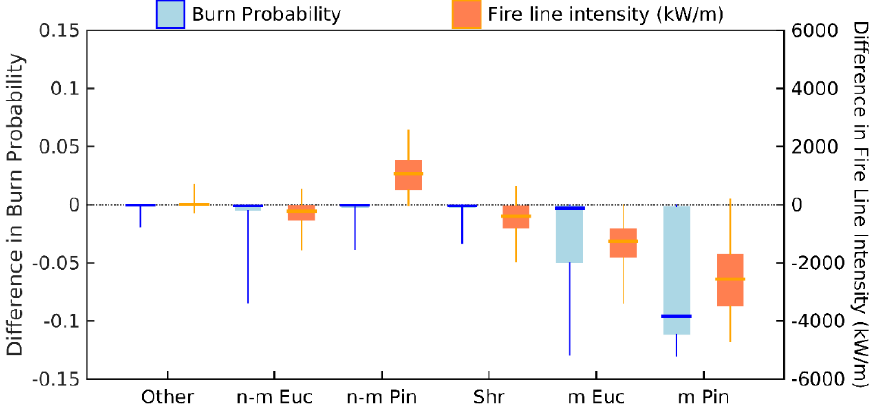
Figure 9. The impact of integrating fuel uncertainty in the estimated burn probability and fireline intensity for the main land use and cover types. Classes are non-managed (or untreated) eucalypt forest (n-m Euc); non-managed (or untreated) pine forest (n-m Pine); shrublands (Shr); managed (or treated) eucalypt forest (m Euc); managed (or treated) pine forest (m Pin). Difference in burn probability was calculated “with fuel uncertainty” − “without fuel uncertainty”.